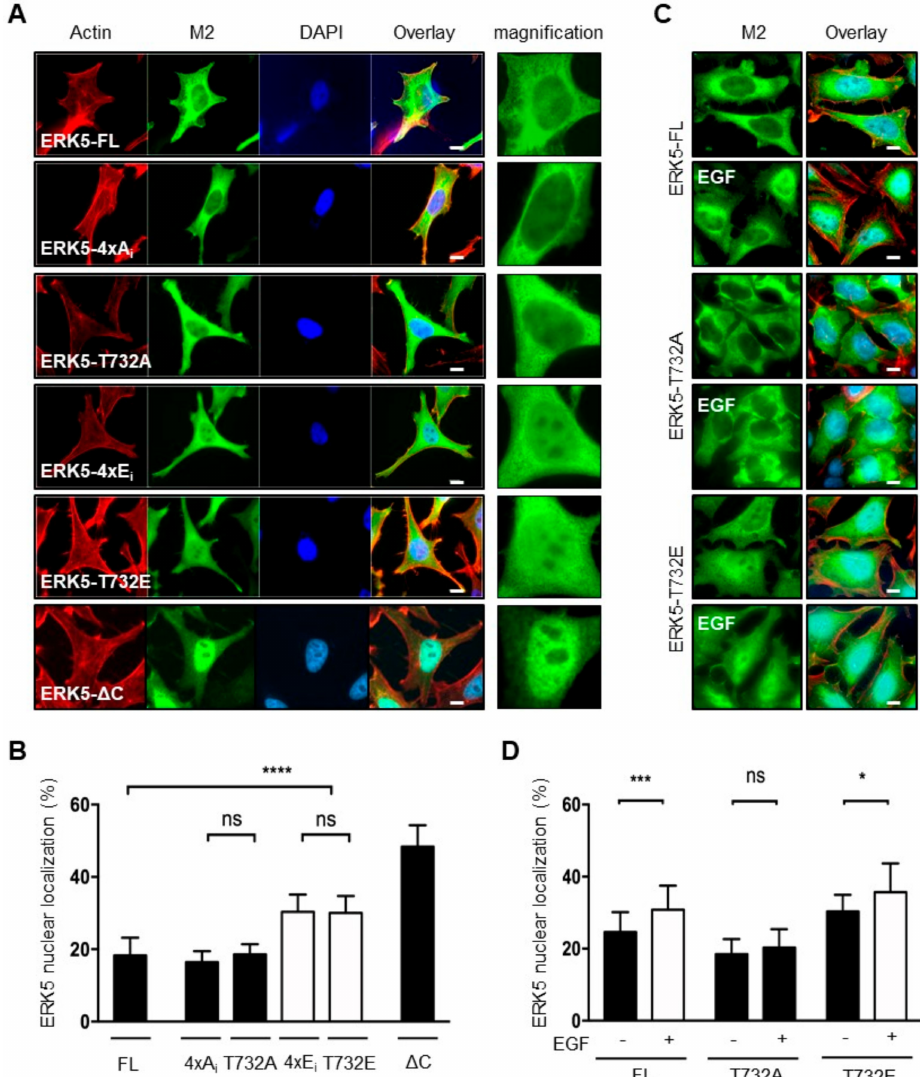
Figure 2. Phosphorylation at Thr 732 promotes the nuclear translocation of ERK5. Recombinant Flp-In HeLa cell lines were grown on glass coverslips and incubated with tetracycline for 24 h before fixation. Where indicated, the cells were stimulated with EGF (20 ng / mL) for 25 min. ( A , C ) Subcellular localization of ectopically expressed ERK5-FL, ERK5- ∆ C and specific phospho-deficient or phosphomimetics mutants were visualized using an antibody to the Flag-tagged epitope (M2, green). Phallodin staining (red) was used to detect actin. Nuclei were detected with DAPI (blue). Scale bars: 10 µ M. ( B , D ) The immunofluorescent signal of the Flag epitope was quantitated with ImageJ. The data expressed as percent of signal in the nucleus correspond to the mean ± SD ( n = 30 cells). * p < 0.05; *** p < 0.001 and **** p < 0.0001 indicate significant di ff erences. ns indicates no statistical di ff